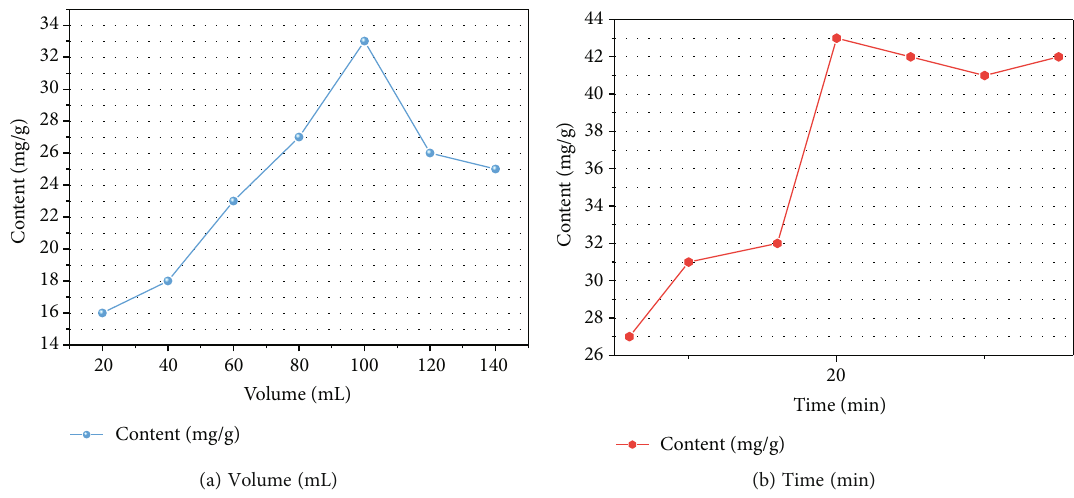
Figure 8: Comparison of the e ff ects of tea-water ratio and brewing time on brewing